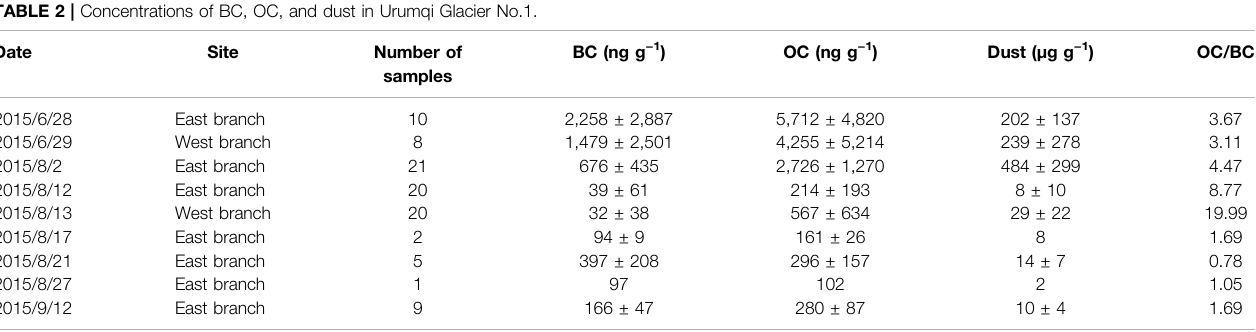
TABLE 2 | Concentrations of BC, OC, and dust in Urumqi Glacier